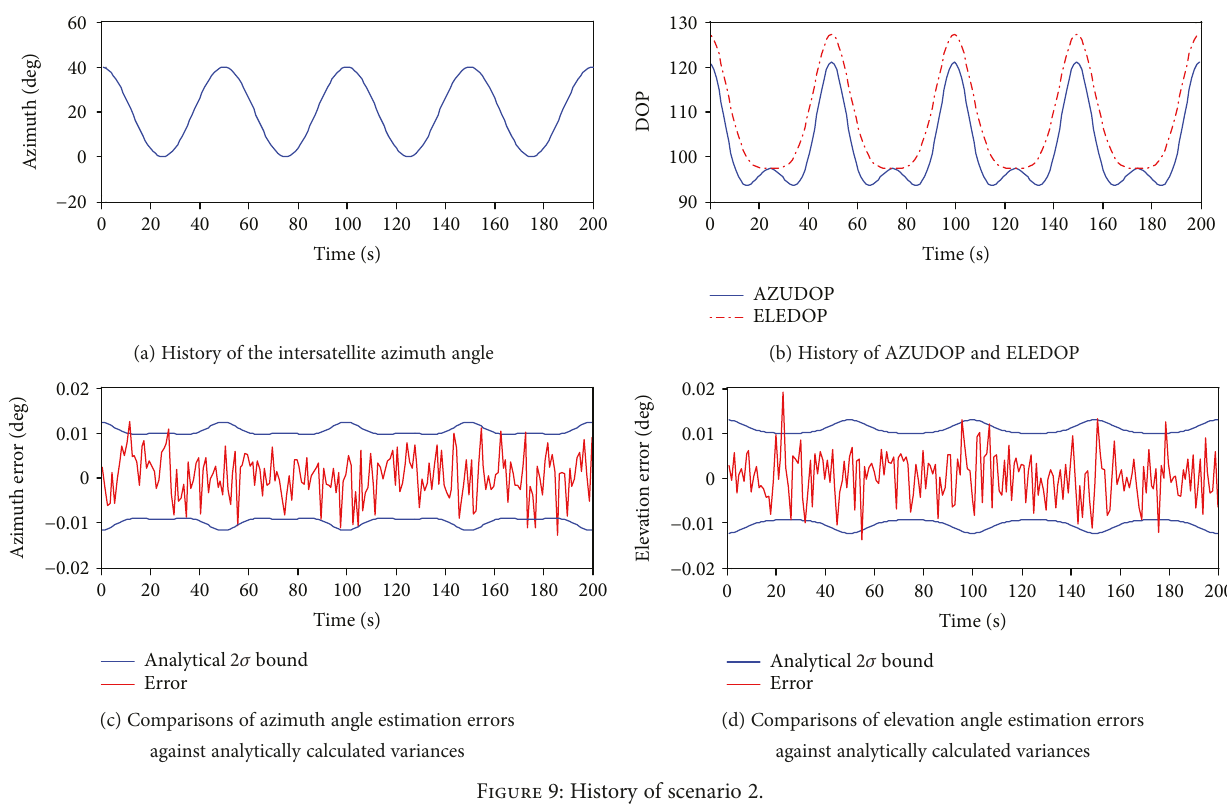
Figure 9: History of scenario 2.